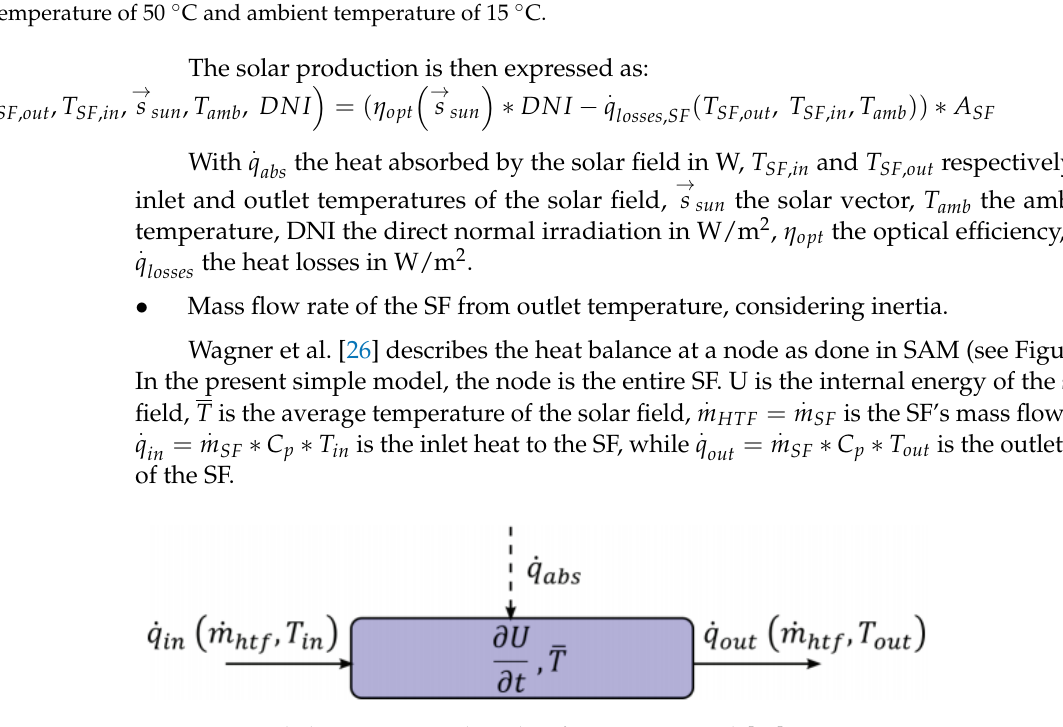
with an inlet temperature of 50 ◦ C and ambient temperature of 15 ◦ C.